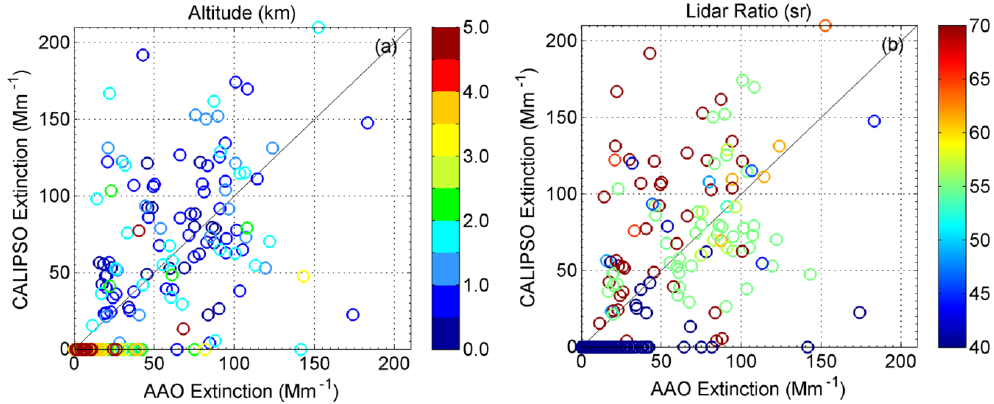
Fig. 15. Individual flight segment extinction comparisons, color coded by (a) altitude and (b) CALIOP lidar ratio.